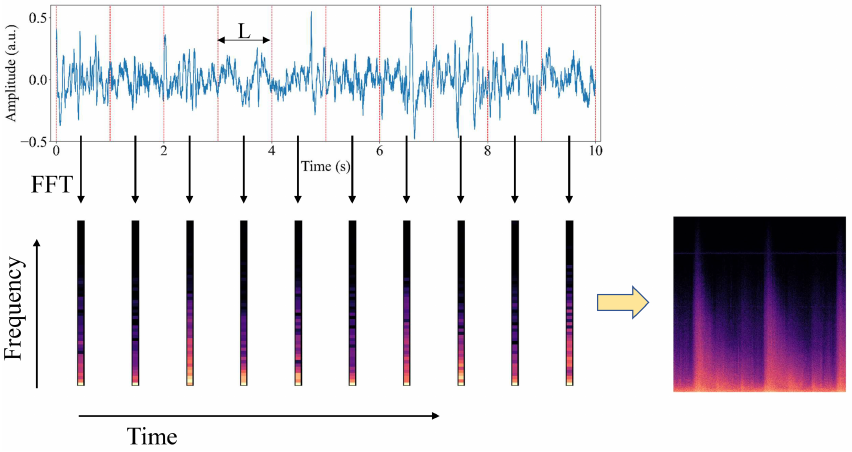
Figure 2. The diagram of short-time Fourier